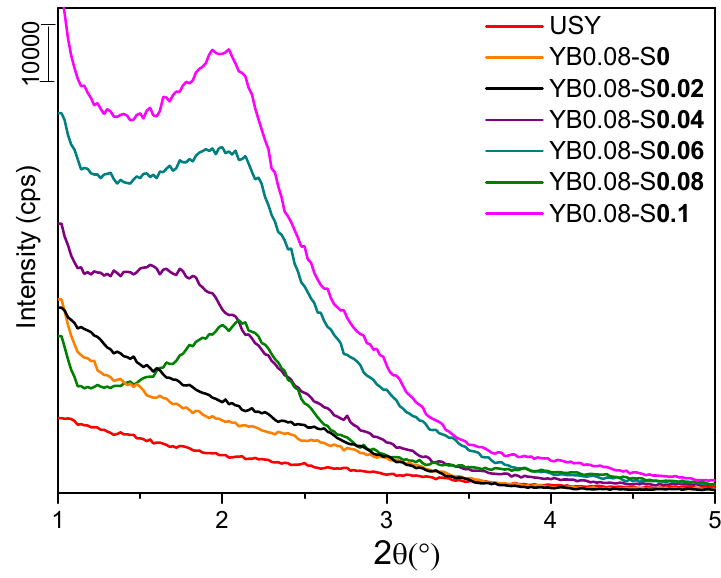
Figure 2. X-ray diffractograms at small angles of the modified zeolites produced using different concentrations of surfactant (CTA + ).